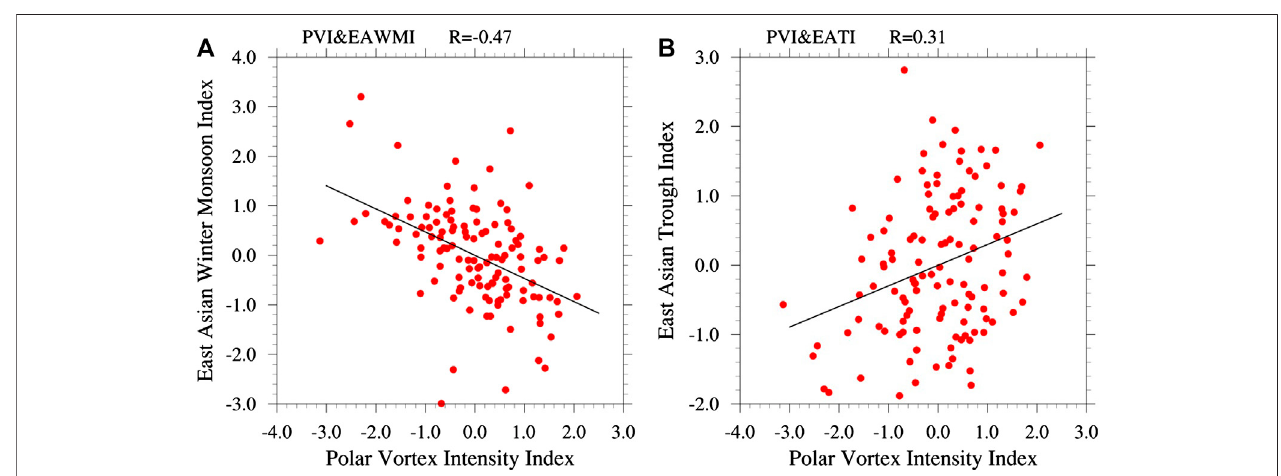
FIGURE 9 | Scatterplots and correlation coef fi cients between the monthly Asia Polar Vortex Intensity Index and (A) East Asian Winter Monsoon Index; (B) East Asian Trough Index from 1979 to 2020 in winter.